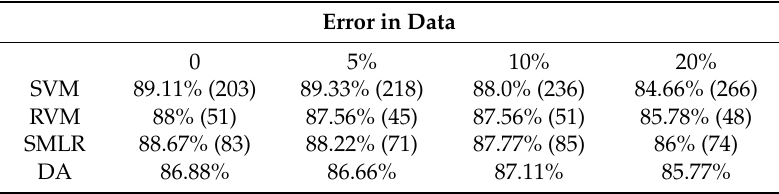
Overall classification accuracy for cases mislabelled to a randomly selected class; DA—discriminant analysis. Values in brackets are the number of support vectors, relevance vectors, and useful kernel basis functions